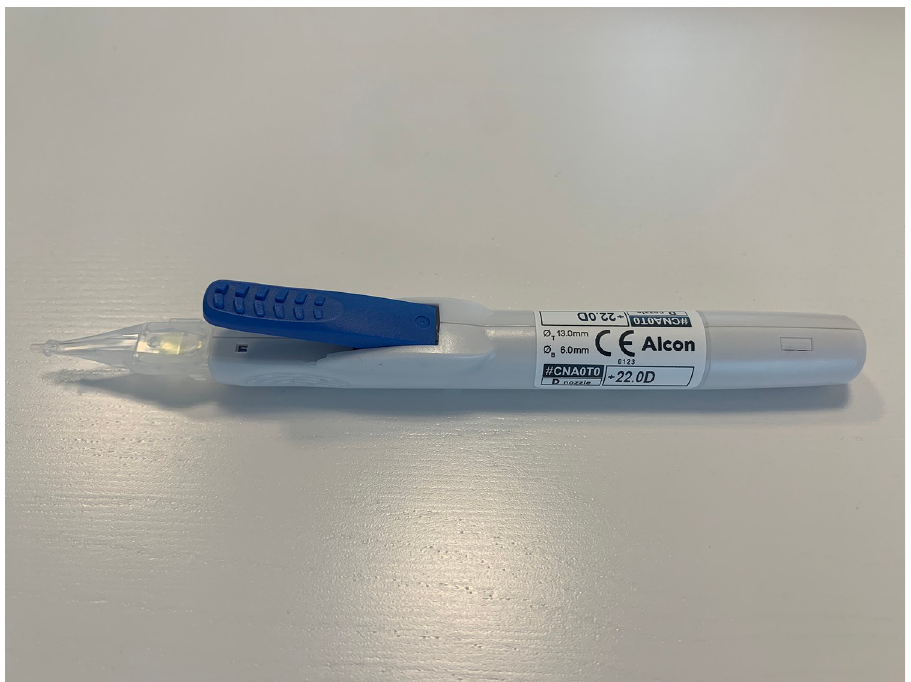
Fig 1. Preloaded AutonoMe 1 injector using compressed CO 2 gas for propel the Clareon 1 IOL.